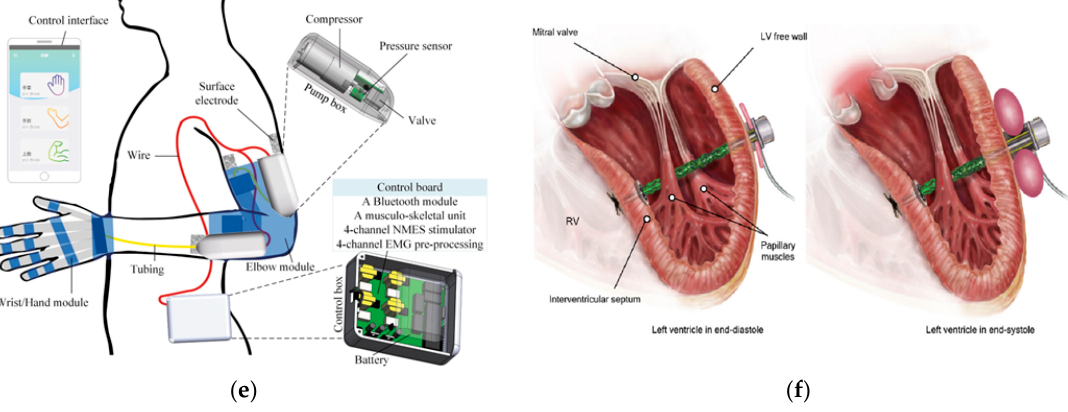
Figure 5. ( a ) Medical robot designed to treat ear diseases [71]; ( b ) rehabilitation glove; reproduced with permission from [53]; published by ELSEVIER, 2020; ( c ) robotic device for hip joint rehabilitation using rotating fluid actuators [76]; ( d ) multimodal locomotion robot for drug delivery; reproduced with permission from [77]; published by ELSEVIER, 2020.; ( e ) wearable device for upper limb recovery after stroke [78]; ( f ) ventricular assist device with McKibben actuator [81].